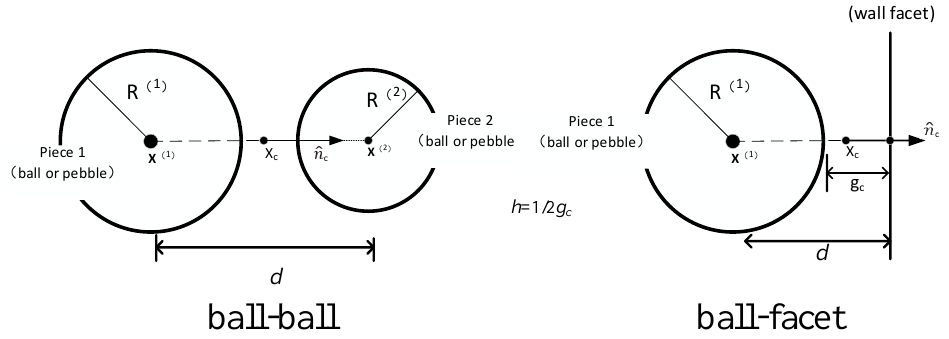
Figure 16. Contact plane position and normal direction of ball–ball and ball–surface basic contact types.